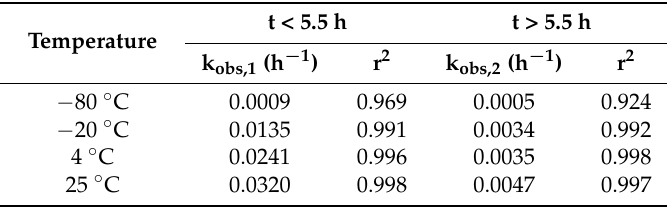
Table 1. Observed reaction rate constants for t < 5.5 h (k obs,1 ) and t > 5.5 h (k obs,2 ) at − 80, − 20, 4 and 25 ◦